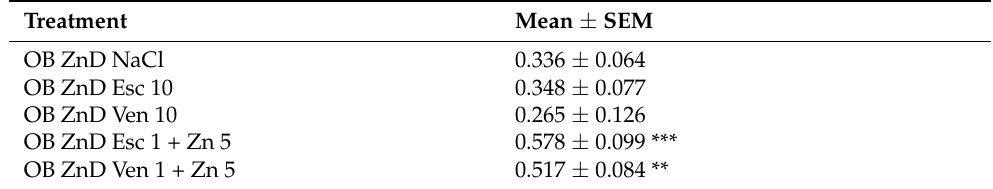
Table 2. The effects of antidepressants (Esc, Ven) and Zn supplementation on serum zinc levels in rats subjected to the OB + ZnD